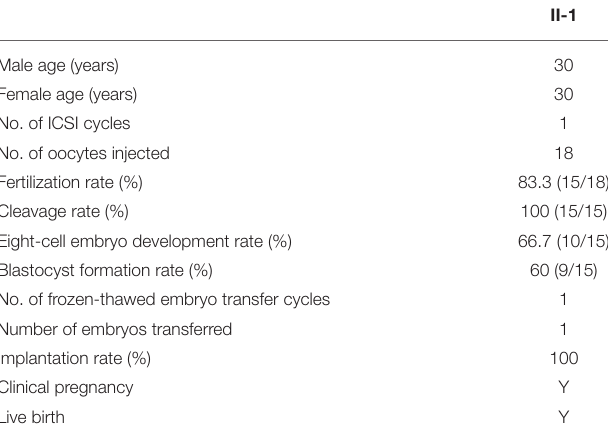
TABLE 2 | ICSI outcomes of the ARMC4- mutated